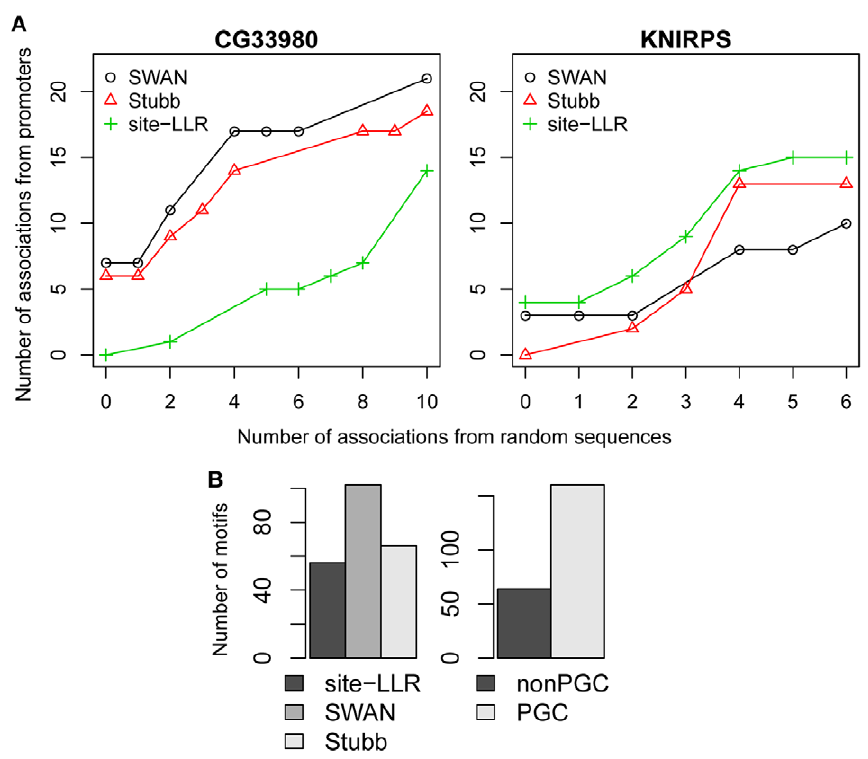
Figure 2. Comparison of motif scanning methods. (A) Two examples of how different motif scanning methods were compared, corresponding to two different motifs (‘‘CG33980’’ and ‘‘KNIRPS’’). The y-axis plots the numbers of associations between the motif and the real promoter set, at different levels of significance (always with p-value , 0.05), and the x-axis shows the number of associations with the shuffled promoter set at the same level of significance. In both examples, there is a method that is superior by all three measures used for comparison: ‘‘strong criterion’’, ‘‘AUC’’ and ‘‘N0’’ (see Methods). For KNIRPS, while site-LLR performs best, Stubb dominates SWAN by the ‘‘AUC’’ measure, SWAN dominates Stubb by the ‘‘N0’’ measure (the value of y at x=0), and there is ambiguity in terms of the ‘‘strong criterion’’. (B) Comparison of different motif scanning methods, using the number of motifs for which each method performed best as per the AUC criterion. Left panel: comparison of site-LLR, SWAN, and Stubb. Right panel: evaluating the effect of ‘‘PGC’’ parameter (see Methods).